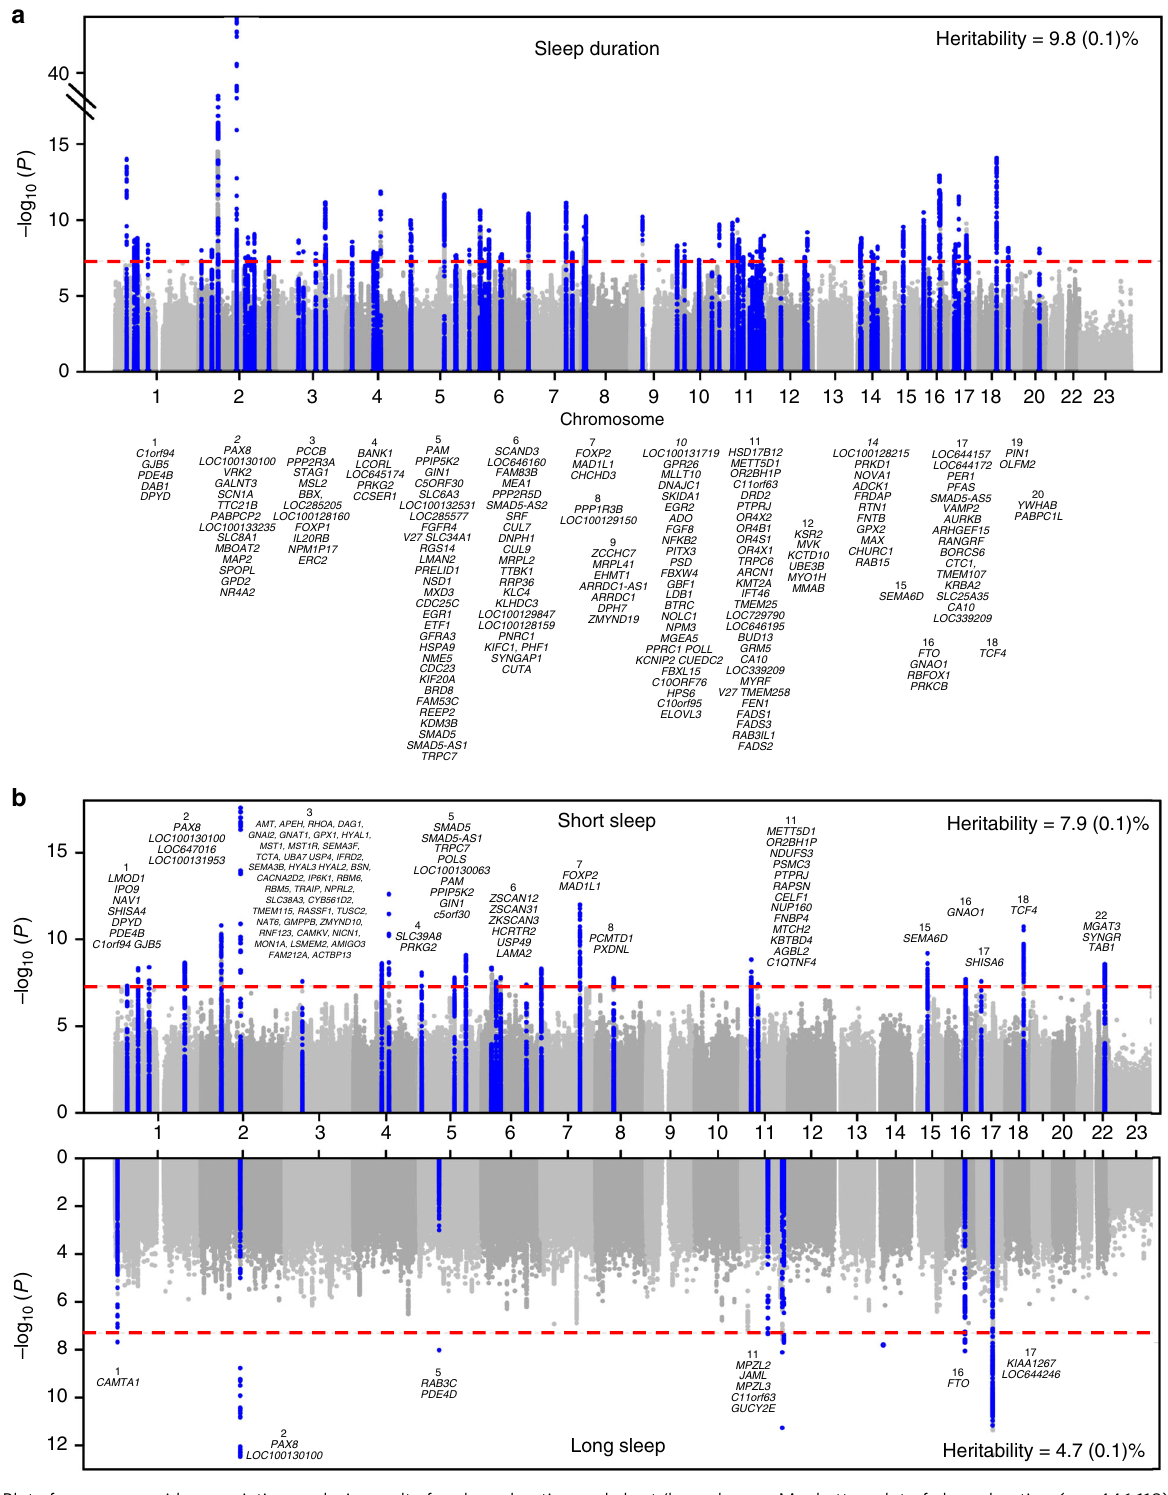
Fig. 1 Plots for genome-wide association analysis results for sleep duration and short/long sleep. a Manhattan plot of sleep duration ( n = 446,118) and b Miami plot of short (cases n = 106,192/305,742) and long (cases n = 34,184/305,742) sleep. Plots show the − log 10 P values ( y -axis) for all genotyped and imputed single-nucleotide polymorphisms (SNPs) passing quality control in each genome-wide association study (GWAS), plotted by chromosome ( x - axis). Blue peaks represent genome-wide signi fi cant loci. Horizontal red line denotes genome-wide signi fi cance ( P = 5 × 10 − 8